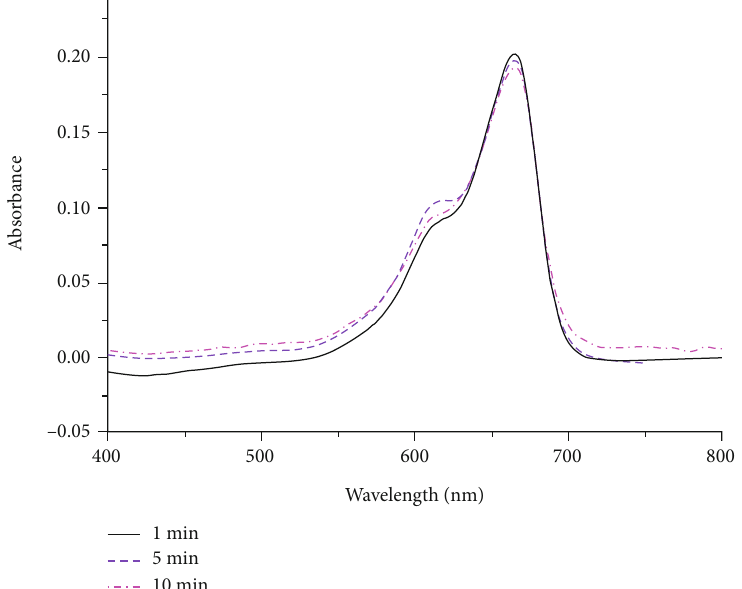
Figure 7: UV – vis spectra of a mixture of methylene blue dye ( 2 × 10 − 5 M , 2ml aqueous solution) and reducing agent NaBH without silver particles.